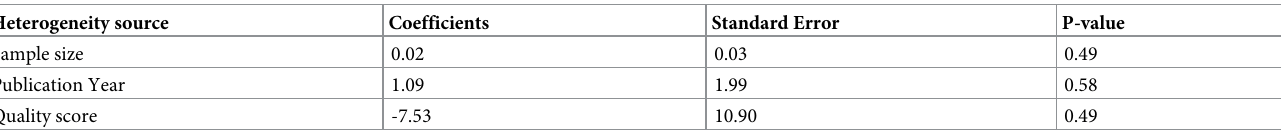
Table 4. Meta-regression analysis of factors associated with heterogeneity.